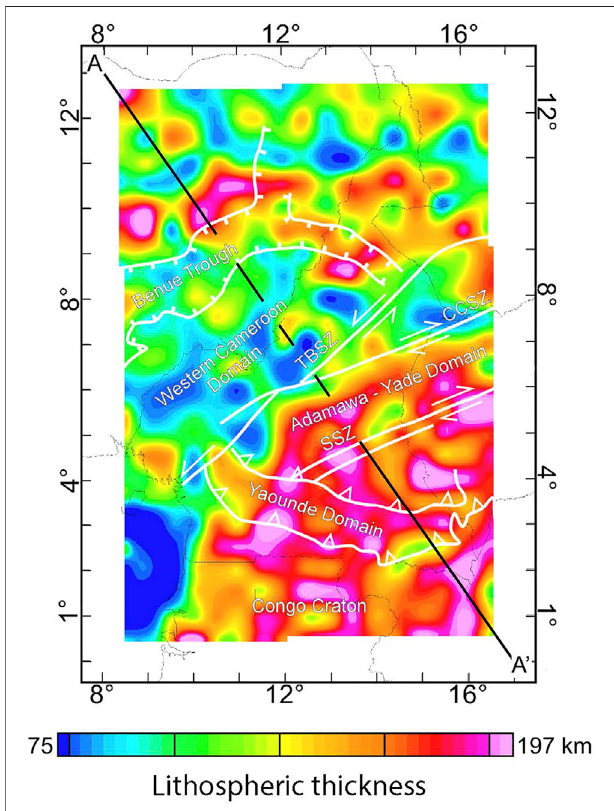
FIGURE 5 | Lithospheric thickness from radially averaged power spectral modeling of WGM2012 Bouguer gravity anomalies (Bonvalot et al., 2012). Reproduced with permission from Goussi Ngalamo et al. (2018). Components of the CASZ are labeled TBSQ = Tchollire-Banyo shear zone, CCSZ — Central Cameroon Shear Zone system, and SSZ = Sanaga Shear